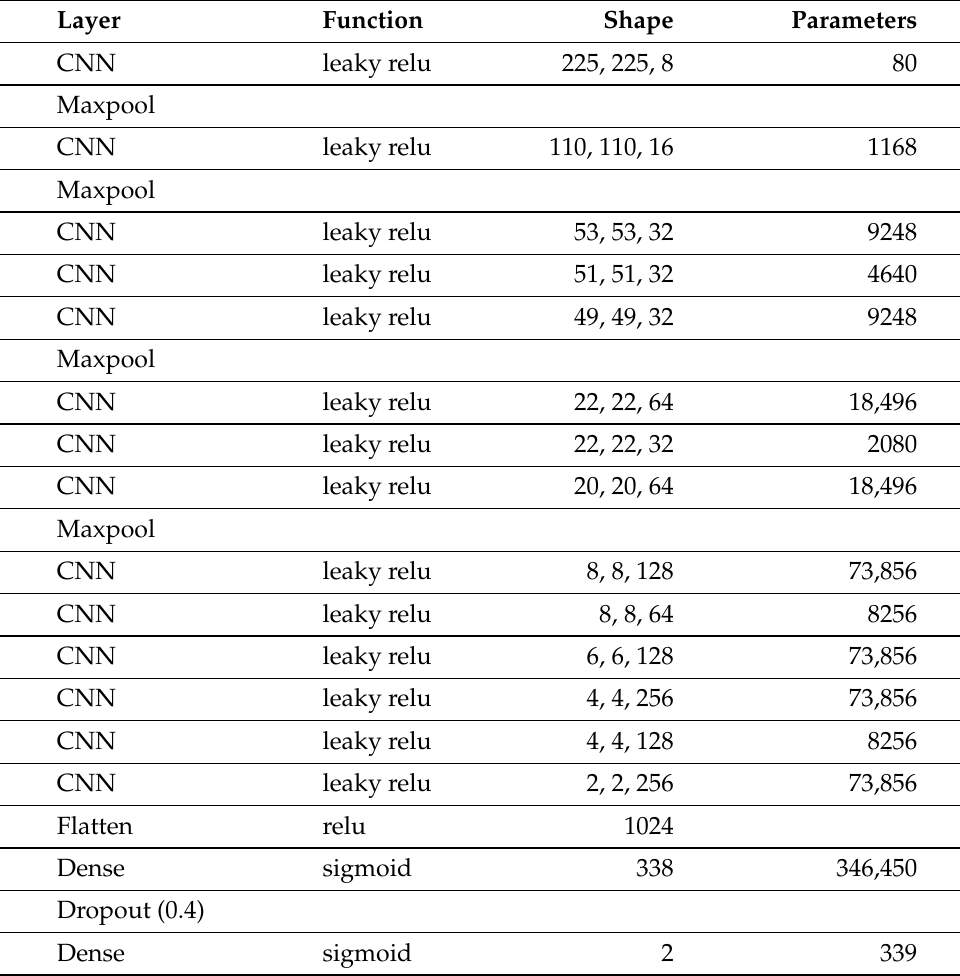
Table A1. Layers of xRGM-NET Version